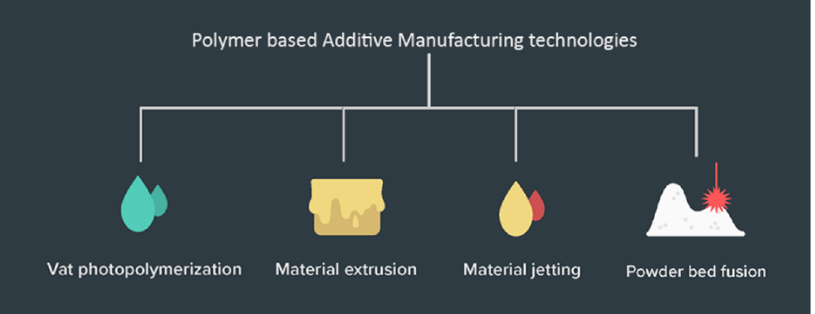
Figure 3. Types of polymer-based AM Technologies.